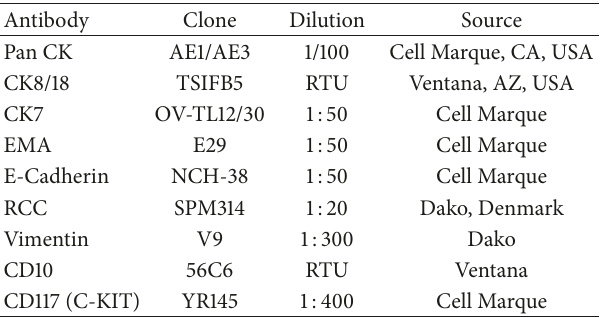
Table 1: Primary antibodies used for IHC, their clone, dilution, and